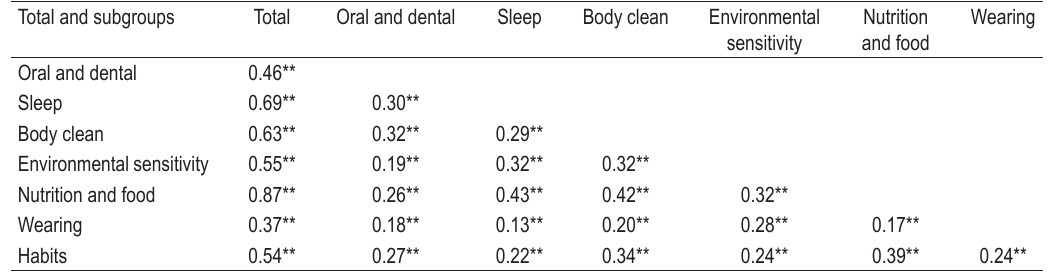
TABLE 4. Correlation matrix of subgroups and total scores for ACHS-C Total and subgroups Nutrition